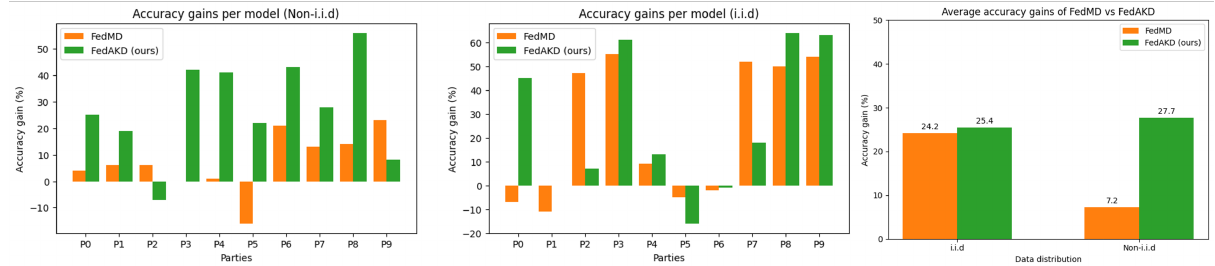
Figure 10. Comparison of individual models’ accuracy gains achieved by our proposed method: FedAKD and FedMD [26] under i.i.d ( middle ) and non-i.i.d ( left ) cases on the HARS dataset. The bar plot to the ( right ) shows the average accuracy gains (across models) under both statistical conditions. FedAKD performs significantly better than FedMD in the non-i.i.d